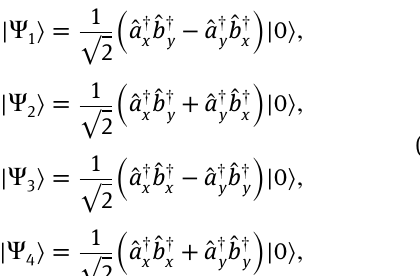
+ E (i.e., -polarized) on x y ( E ), E ( − E ), i E ( E ), and y x x y y x